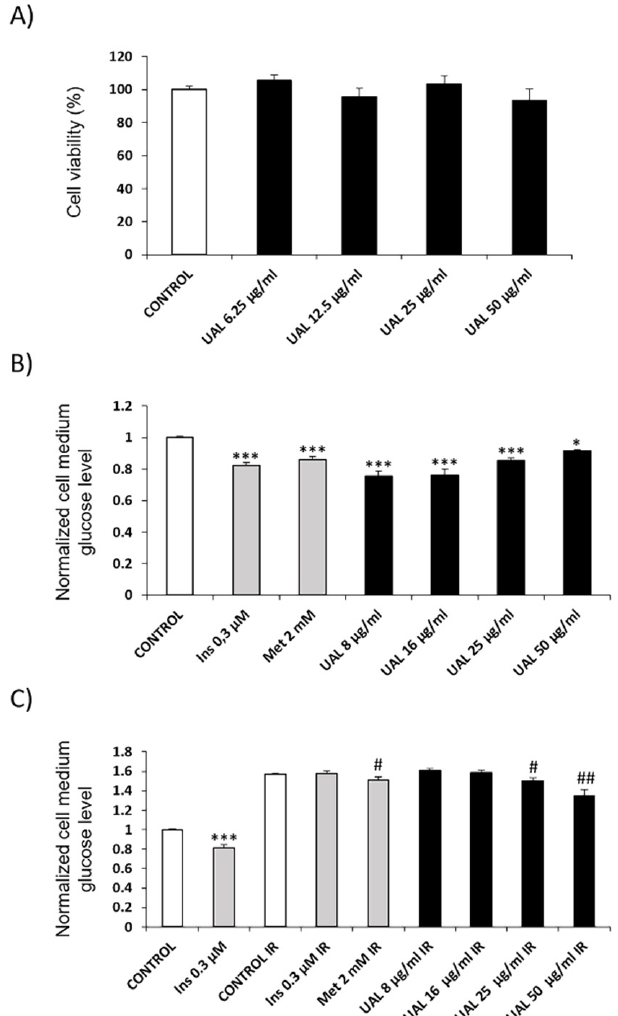
Figure 2. Effect of UAL on cell viability and glucose uptake in C2C12 cells. ( A ) C2C12 cells were treated with various doses (0–50 µ g/mL) of UAL. Cell viability was measured by the MTT assay after 4 h of treatment. The percentage of viable cells was calculated by defining the cell viability without treatment as 100%. Values are expressed as mean ± SEM of three independent experiments each one performed in triplicate. ( B ) Non-insulin-resistant C2C12 cells were treated with various doses (8–50 µ g/mL) of UAL. Insulin (Ins) and metformin (Met) were used as positive controls. Values are expressed as mean ± SEM of three independent experiments each one performed in